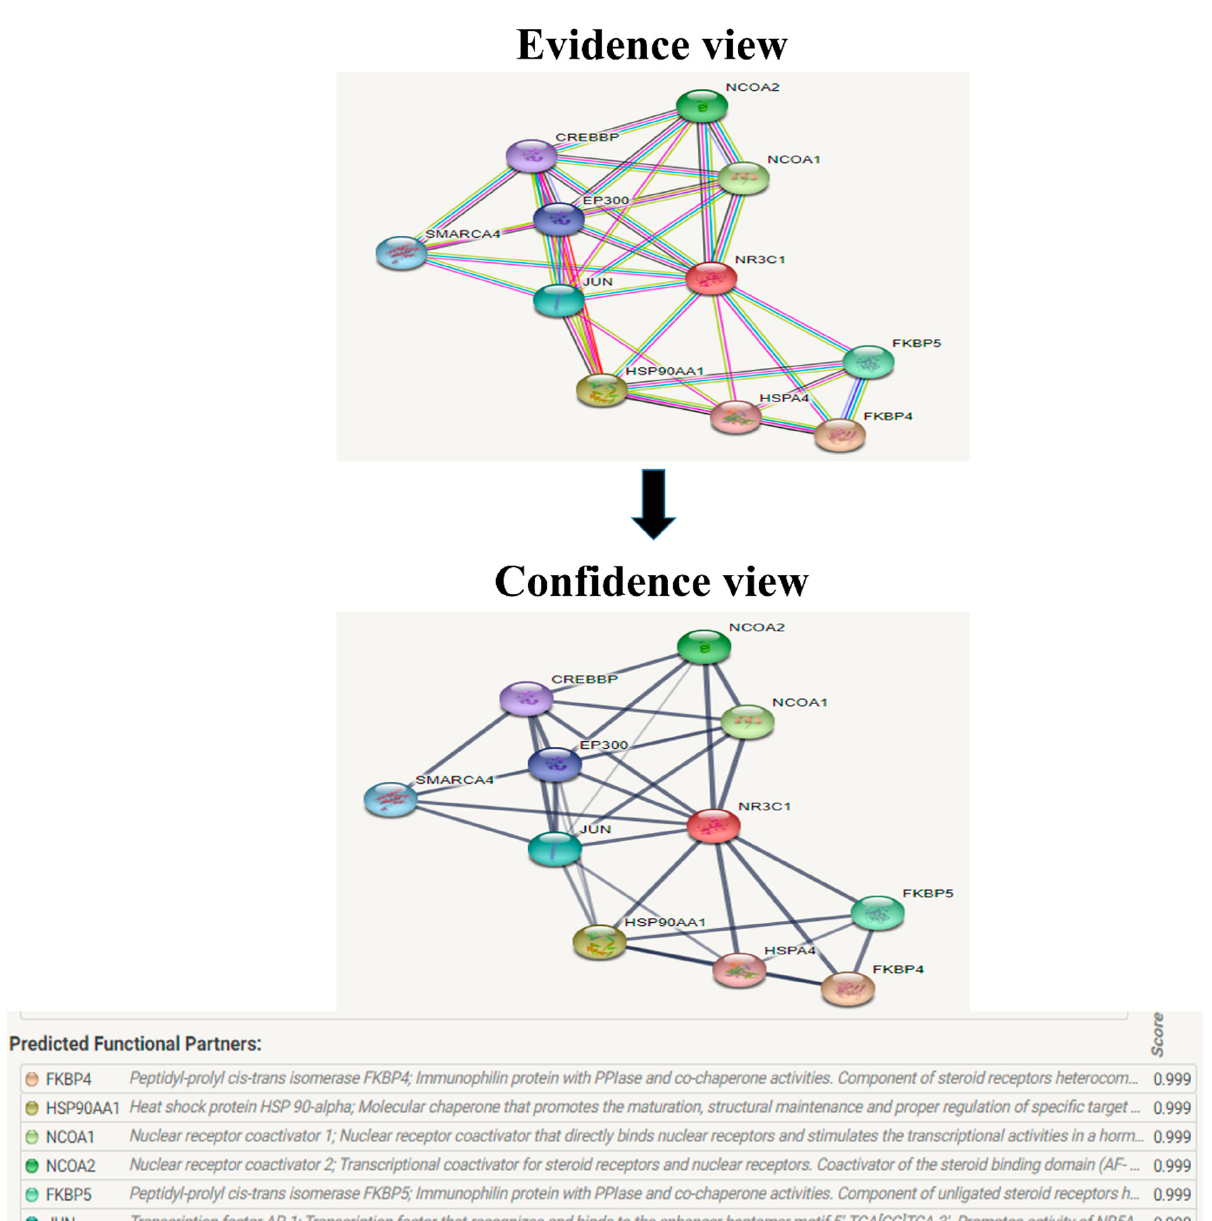
Figure 11. The protein NR3C1 interacts with a total of 10 other proteins. The evidence view and confidence view are given, while the dark blue lines denoting a strong correlation.